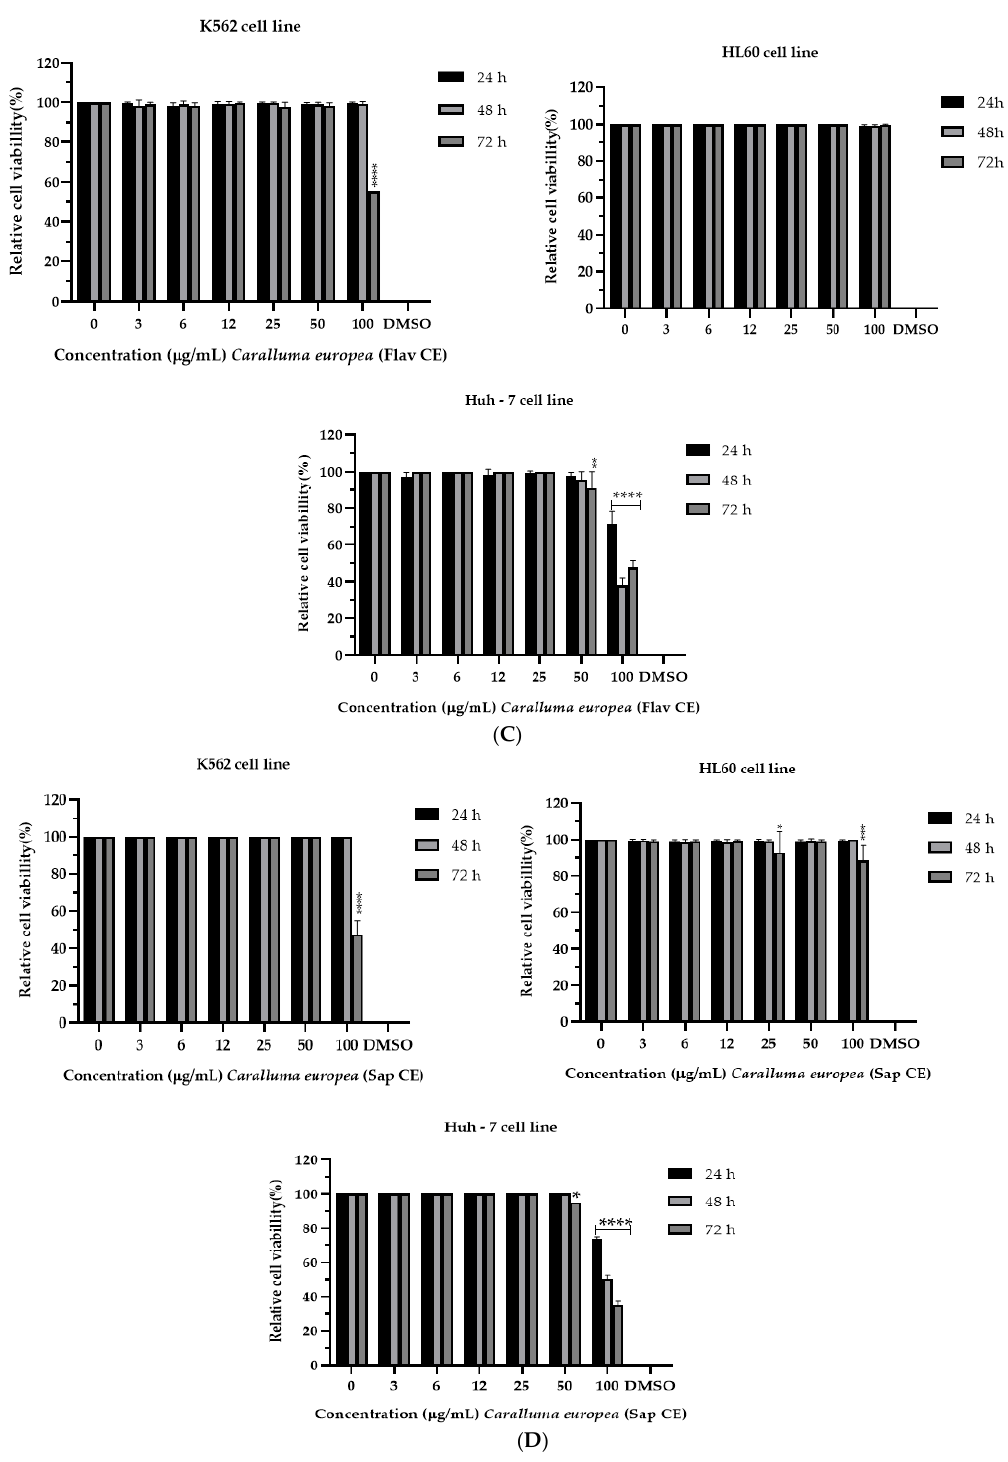
Figure 1. Cytotoxicity of the C. europaea extracts for K562, HL60, and Huh-7 cell lines. ( A ): Hydroethanolic extract; ( B ): Polyphenolic extract; ( C ): Flavonoids extract; ( D ): Saponins extract, after 24, 48, and 72 h of treatment with different concentrations of the C. europaea extracts. The wavelength of 570 nm was used to measure the absorbance. The results are expressed as mean ± SD of three experiments. The error bars represent the standard deviation of cell viability at each concentration tested. Cell viability was assessed through MTT assay. Values significantly different compared to negative control * p < 0.05; **: p < 0.01; *** p < 0.001; **** p < 0.0001.